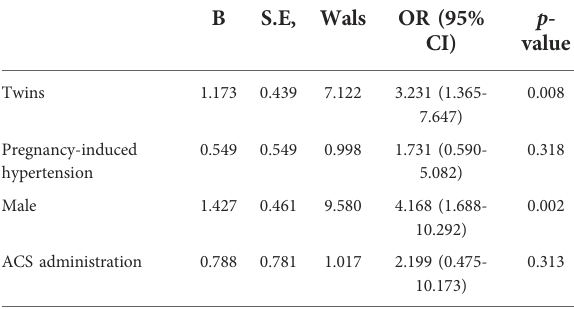
TABLE 3 The effect of pregnancy-induced hypertension, twins, sex and ACS administration on the risk of